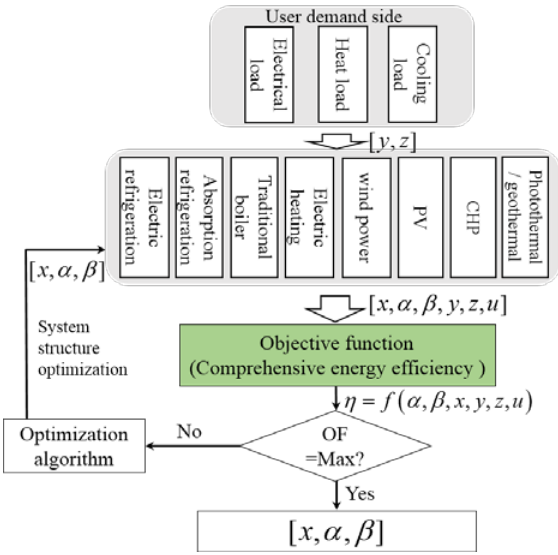
Figure 5. The schematic diagram of the structural optimization of integrated energy system.